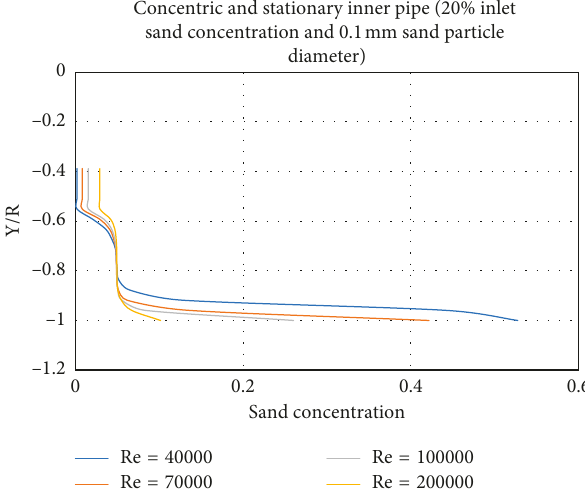
Figure 10: Effect of fluid flow on particle concentration profile (concentric annuli with stationary inner